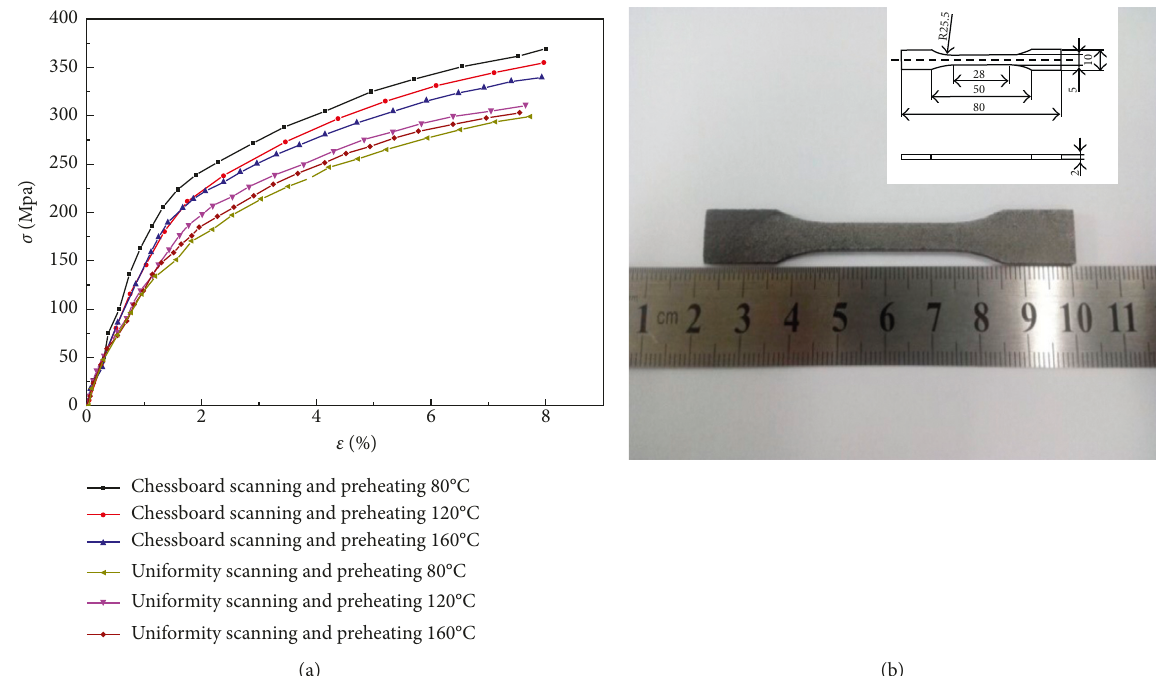
Figure 3: (a) The plots of engineering stress-strain curves of test samples manufactured at different preheating temperatures and scanning modes. (b) Dimensions and actual photographs of tensile specimens.